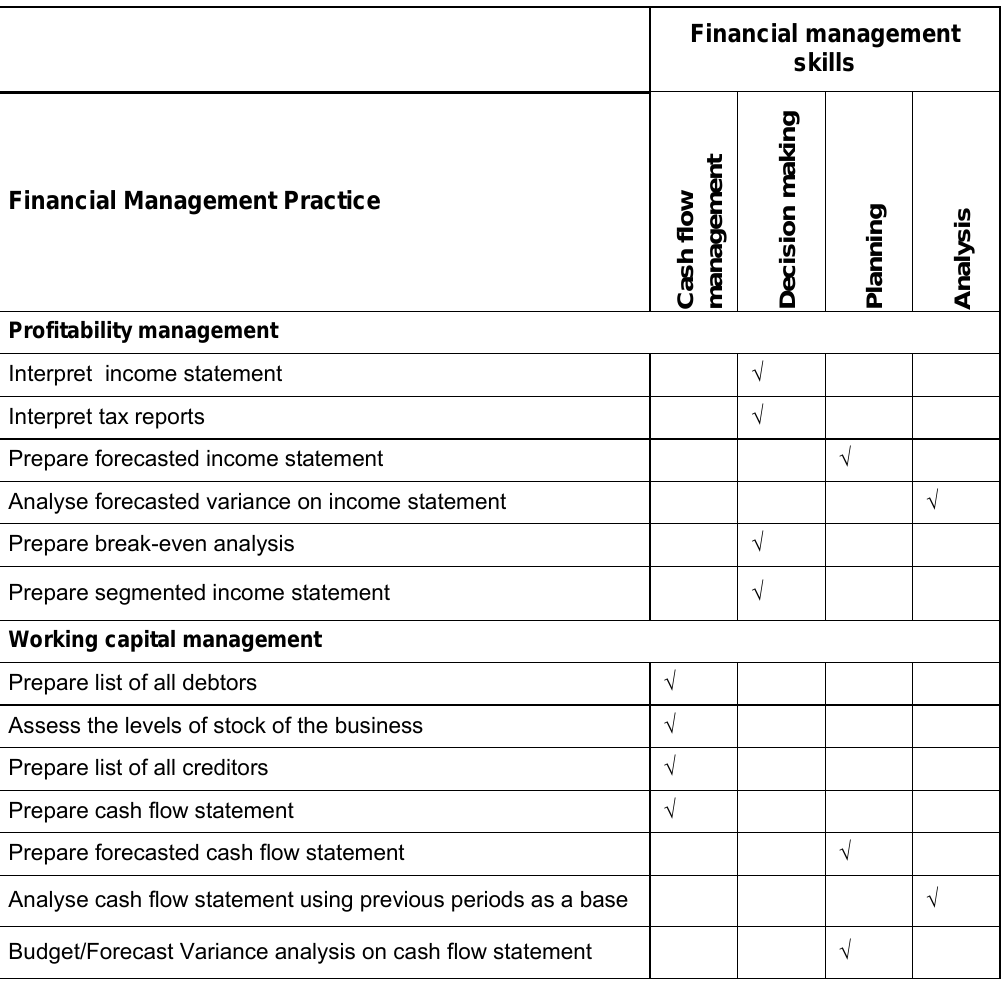
Table 3: Financial management practices linked to financial management